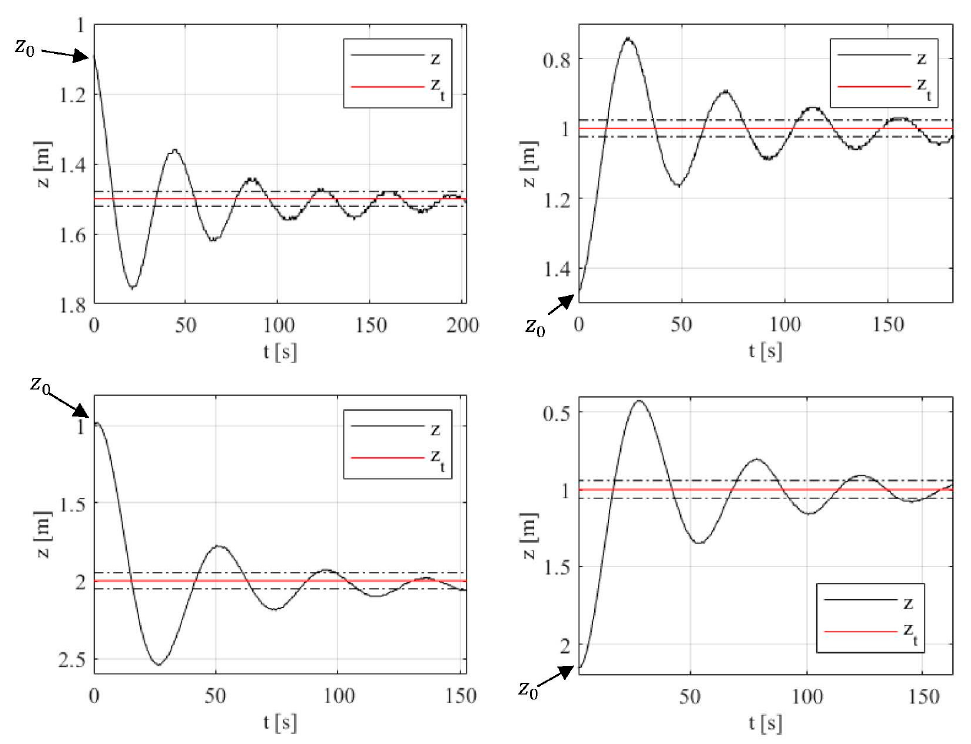
Figure 10. PI depth controller experimental results: z is the BCD depth, z t is the target depth and the dashed dot lines represent a ± 5% band around z t .